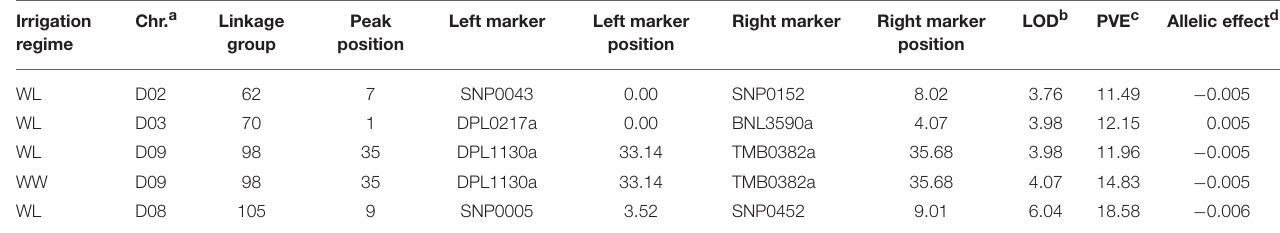
TABLE 7 | Summary of quantitative trait loci (QTL), detected at an experiment-wise Type I error rate of 5%, for leaf thickness in the upland recombinant inbred line (RIL) population. The RIL population was evaluated under water-limited (WL) and well-watered (WW) conditions in 2010–2012. Irrigation Chr. regime